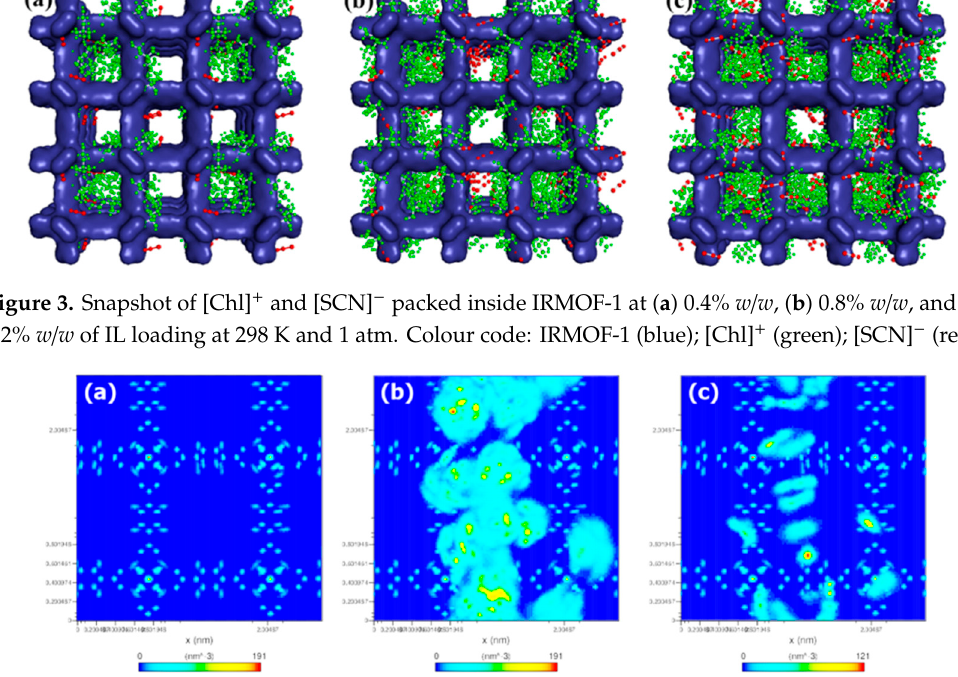
Figure 4. Density map of ( a ) IRMOF-1, ( b ) [Chl] + , and ( c ) [SCN] − distributed inside the pore volume.